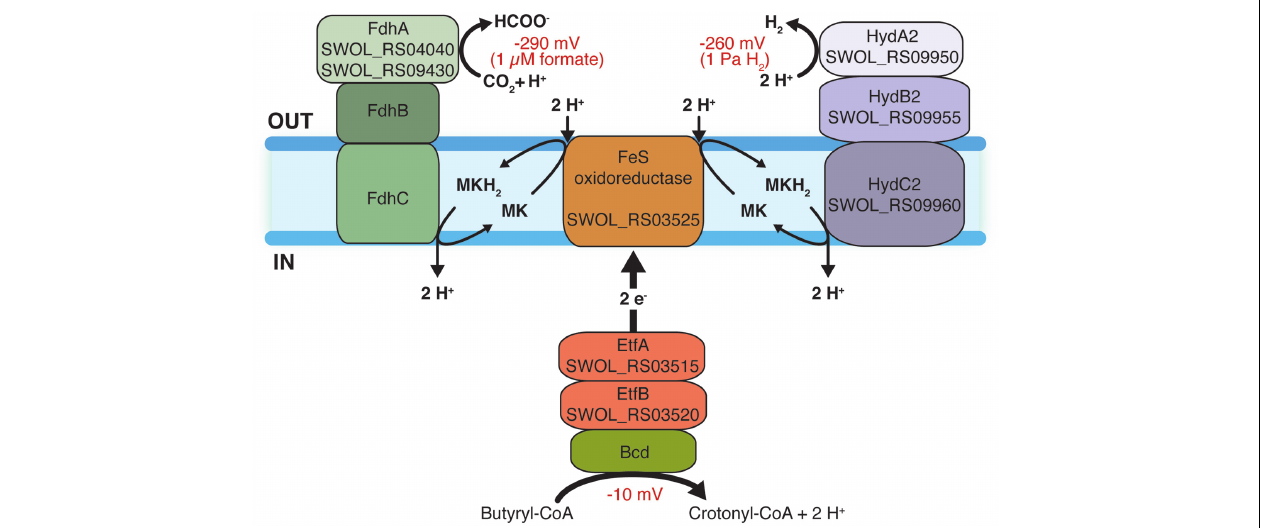
FIGURE 3 | Model for reverse electron transfer during syntrophic butyrate oxidation by S. wolfei . Electrons from butyryl-CoA dehydrogenase are transferred to the iron-sulfur (FeS) oxidoreductase (SWOL_RS03525 gene product) by (EtfAB2, SWOL_RS03515 and SWOL_RS03520). FeS oxidoreductase and an [FeFe]-hydrogenase form separate complexes in the membrane. Electrons from FeS oxidoreductase reduce menaquinone with protons consumed at outside surface of the membrane. The [FeFe]-hydrogenase oxidizes menaquinol with the release of protons on the inside of the cell. Menaquinol oxidation could also occur by a membrane-bound formate dehydrogenase (Fdh). The consumption of protons during hydrogen or formate production and the inward flow of protons would drive the unfavorable redox change involved in hydrogen or formate production from electrons generated during the oxidation of butyryl-CoA. Redox values for butyryl-CoA oxidation at standard conditions and hydrogen and formate metabolism at 1 Pa and 1 µ M, respectively, are given. Abbreviations: Bcd, butyryl-CoA dehydrogenase; ETF, electron transfer flavoprotein); Hyd, hydrogenase; Fdh, formate dehydrogenase; MK, menaquinone; and MKH 2 , menaquinol. Numbers in parentheses are locus tag designations of the respective genes.